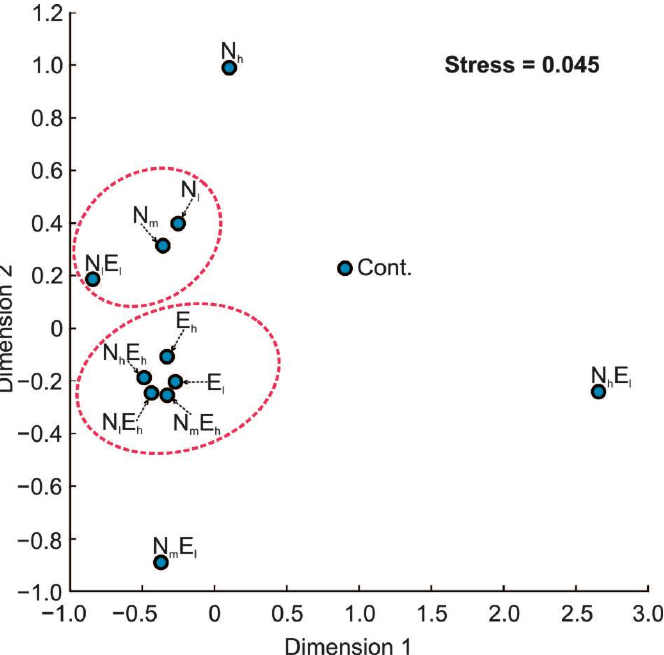
Figure 6. Bray–Curtis-based NMDS analysis of the relative respiration of 31 different carbon sources by D. magna gut microbiota from the control (Cont.), and from variants of the combination of two variables: (1) NPs in low, medium, and high concentrations (N l , N m , N h , respectively) and (2) enrofloxacin in low and high concentrations (E l and E h , respectively).